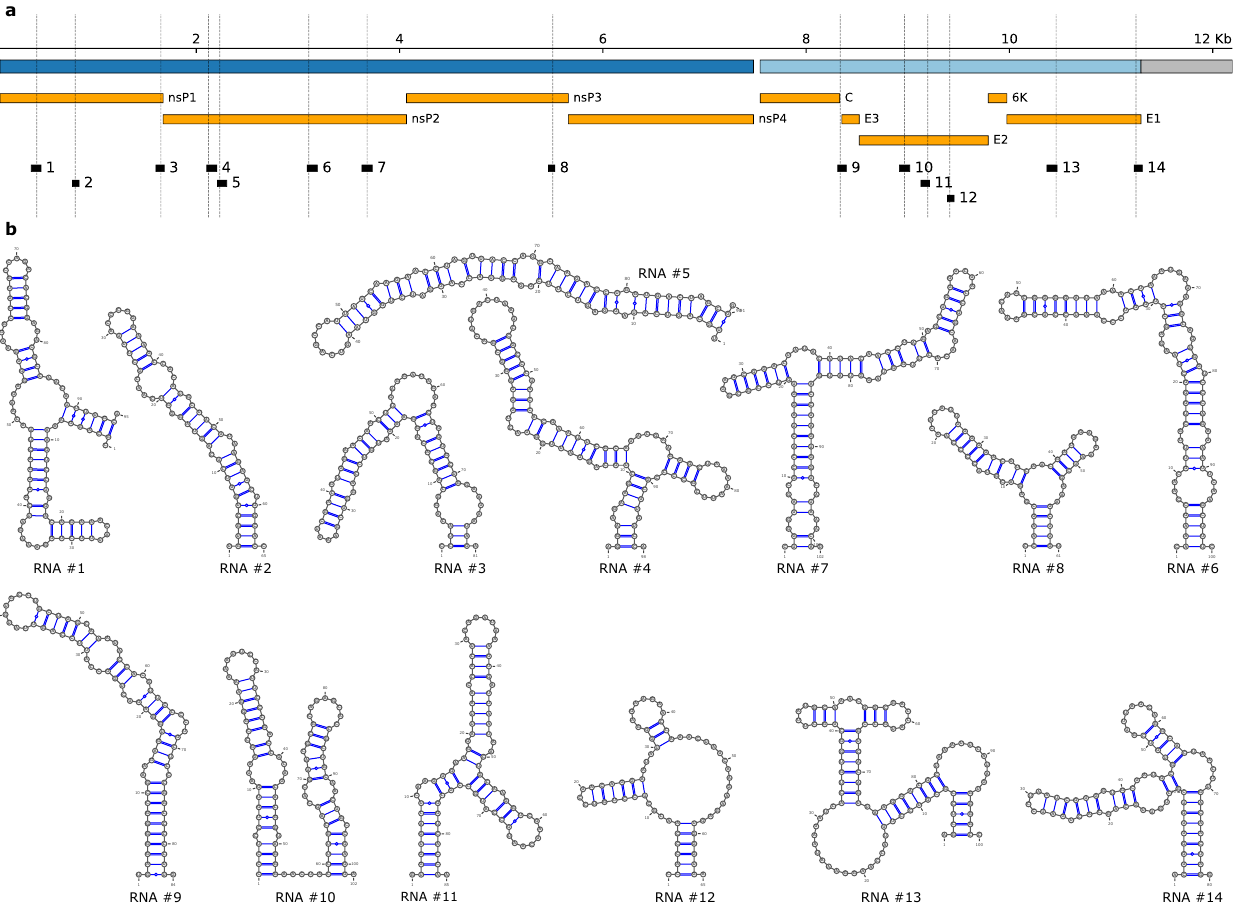
Figure 2. ( a ) Schematic genome representation of CHIKV isolate KT327163.2, which is used as the reference strain here. Open reading frames (ORFs) encoding non-structural and structural polyproteins are depicted in dark blue and light blue, respectively, UTRs in grey. Protein products are shown in orange. Locally stable RNAs that overlap single nucleotide variants (SNV) loci (indicated by dashed lines) are depicted in black. Genome tracks were created using pyGenomeTracks [58]. Genomic coordinates of candidate RNAs and SNVs are listed in Table 3. ( b ) Predicted minimum free energy (MFE) structures of the 14 locally stable RNAs in the reference